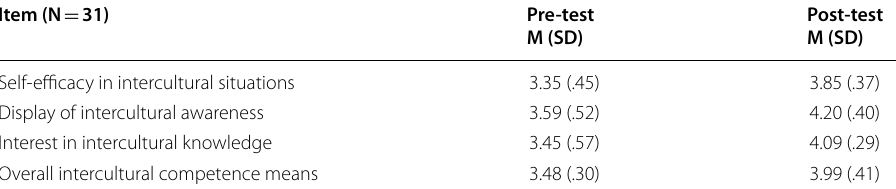
Table 9 Intercultural competence rating scale (experimental group) Item (N 31) =